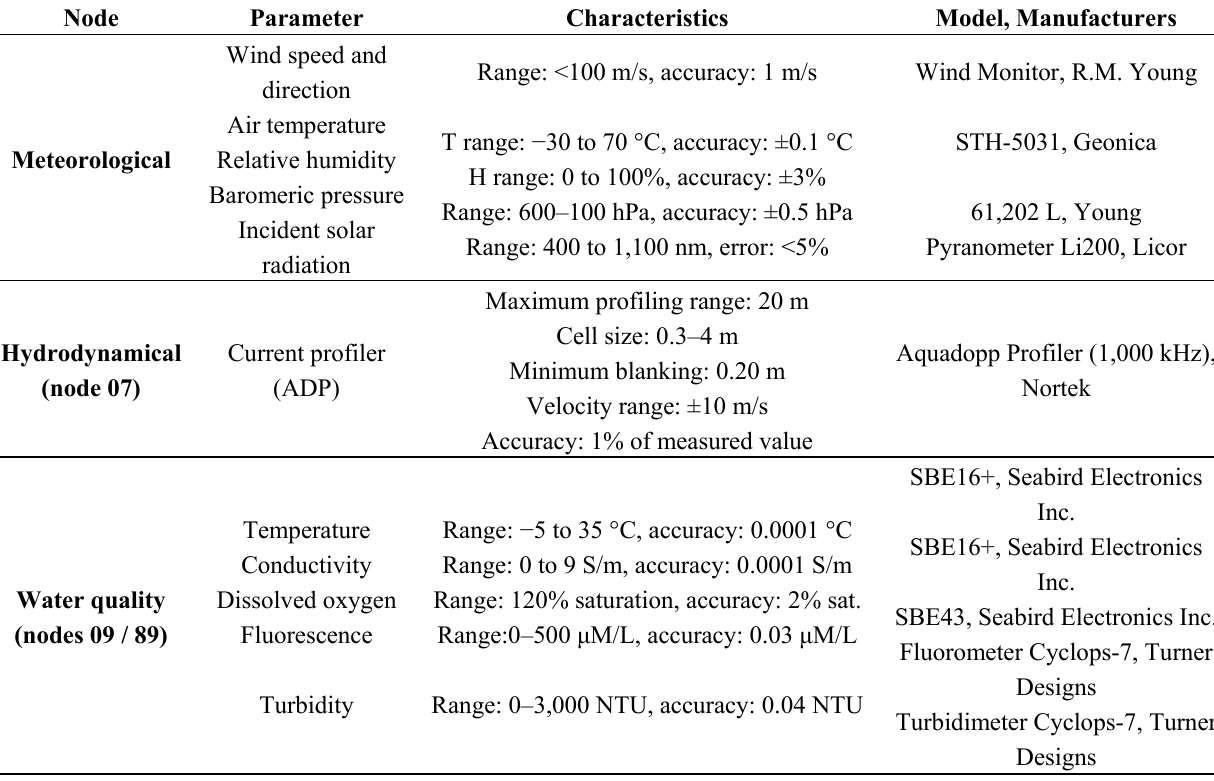
Table 1. Sensors equipment installed in different